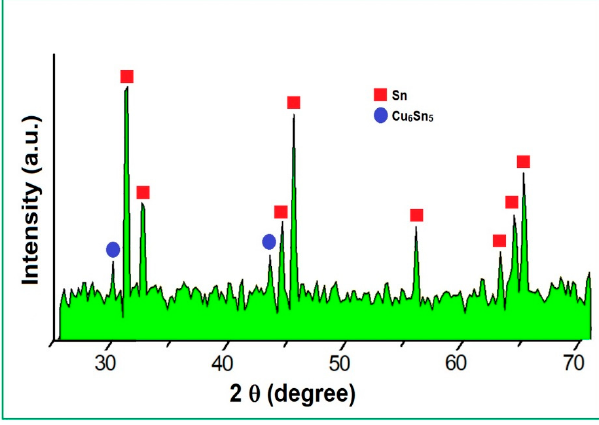
Figure 1. XRD pattern of the Sn-0.7 wt. % Cu powder after milling for 45 h.